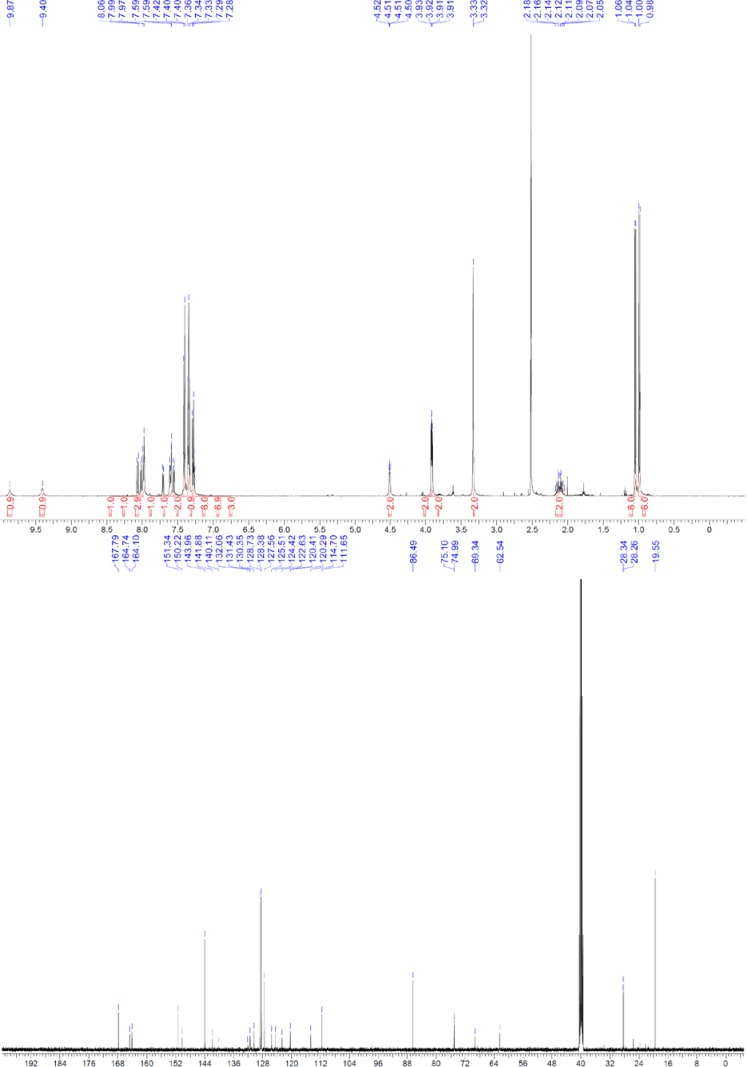
1H and 13C NMR of compound 9.